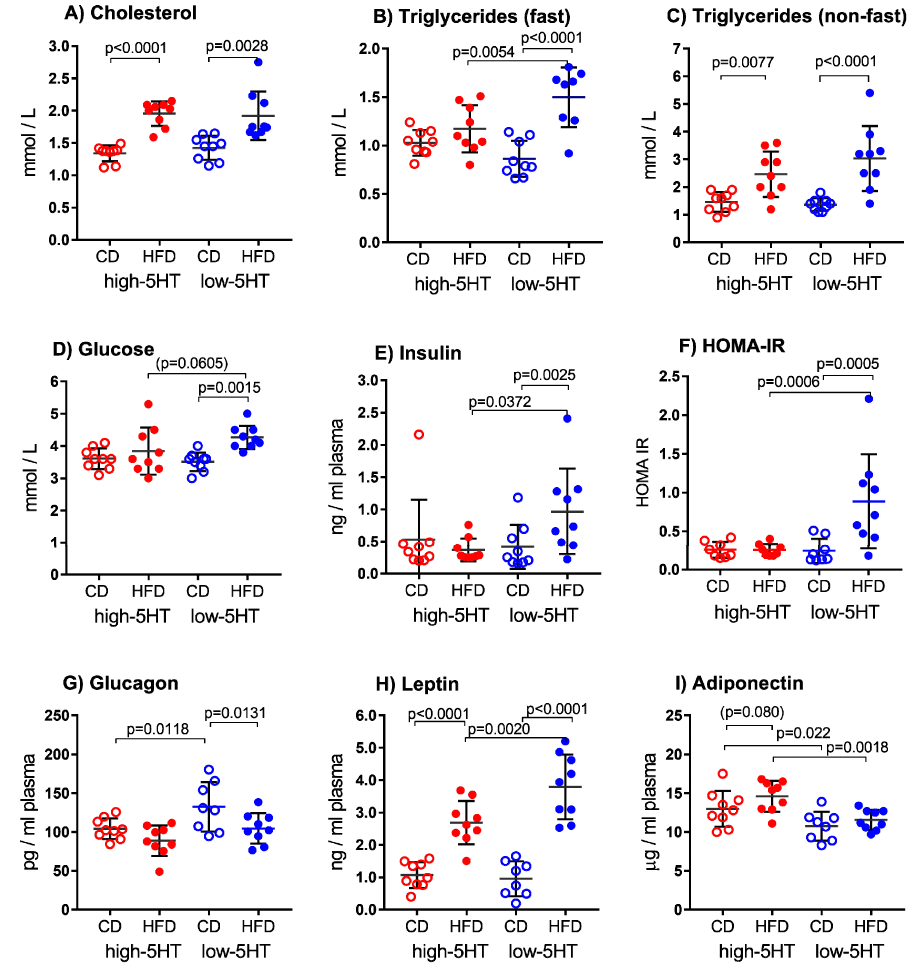
Figure 5. Blood biochemical parameters in animals from the high-5HT and low-5HT sublines after 4.5 ( A , B ) or 9–10 ( C – I ) weeks on control diet (CD) or high-fat diet (HFD), measured after overnight (12 h) fasting of animals (except in C). Data are presented as individual values and mean ± SD; N = 9 per group; p -values obtained by LSD or Dunn’s post-hoc test after one-way ANOVA or Kruskal-Wallis test, as appropriate, are indicated on figures. HOMA-IR = Homeostatic Model Assessment for Insulin Resistance, calculated from glucose and insulin fasting plasma concentrations.